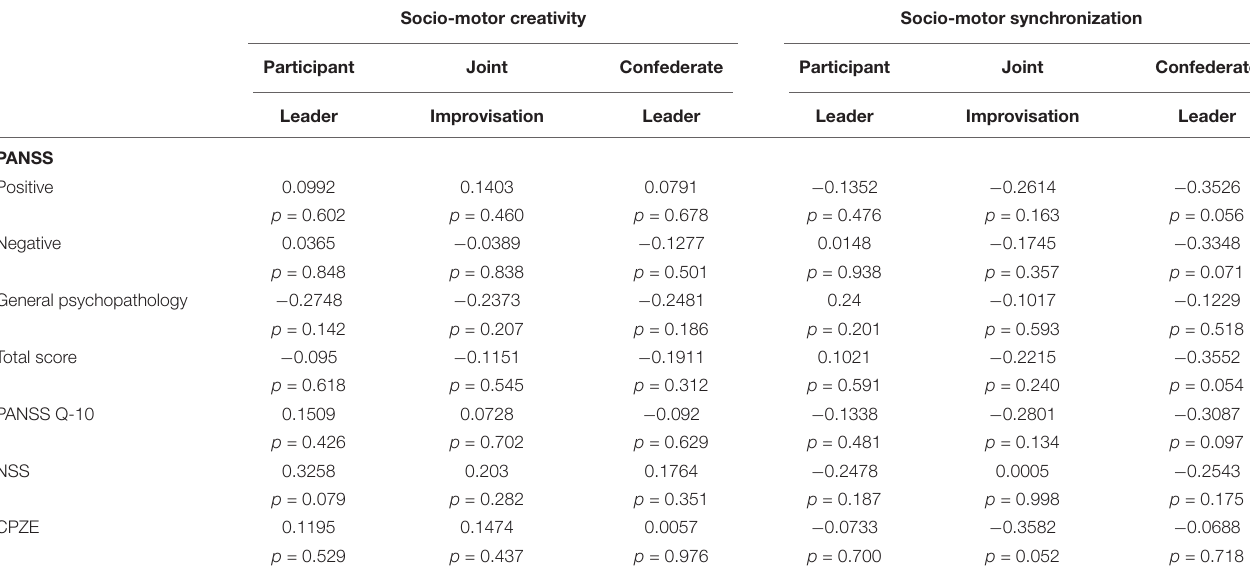
TABLE 2 | Correlation between symptomatology and socio-motor variables for the schizophrenia